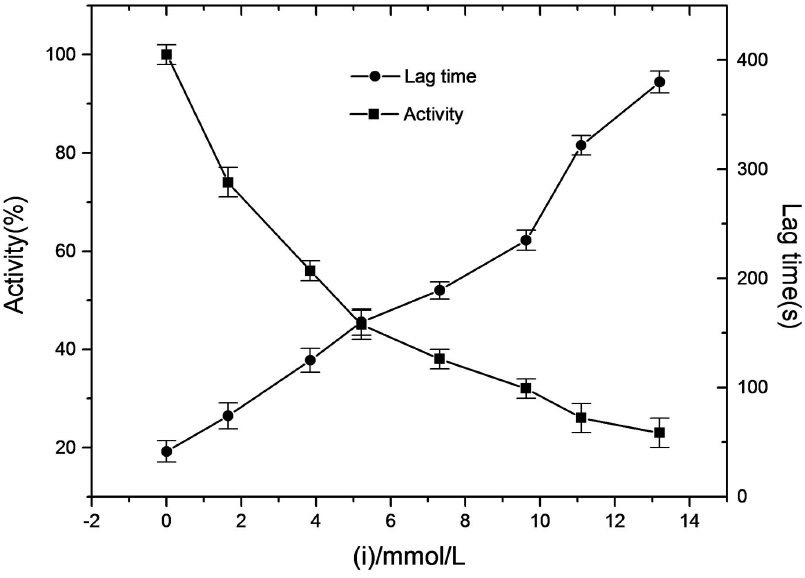
Figure 2. Effects of a -arbutin on the enzyme activity and the lag time of monophenolase activity of mushroom tyrosinase. Assay conditions: 3.0 ml 50 mM phosphate buffer pH 6.8, containing 0.5 mM L-tyrosine. The reaction was started by the addition of the enzyme (20 m g/ mL).